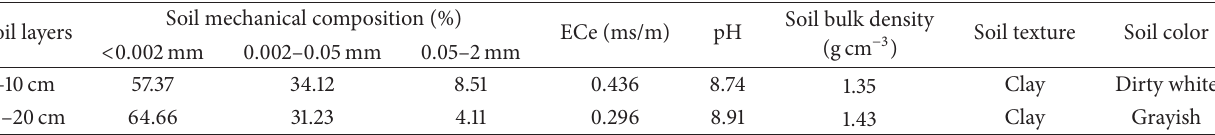
Table 1: Basic soil properties of the initial soil profile.